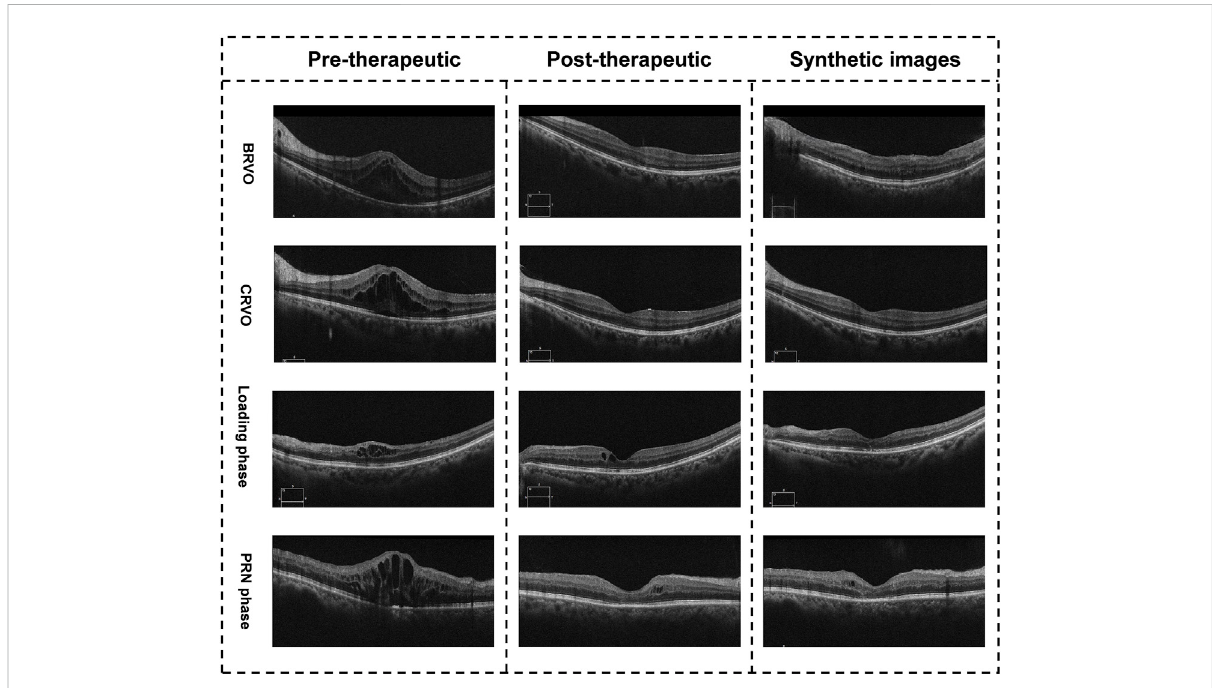
FIGURE 4 Illustration of the synthetic OCT images with different types of macular edema. The images in the right column are synthetic post-therapeutic images generated by pix2pixHD. The images in the middle column are the real images.